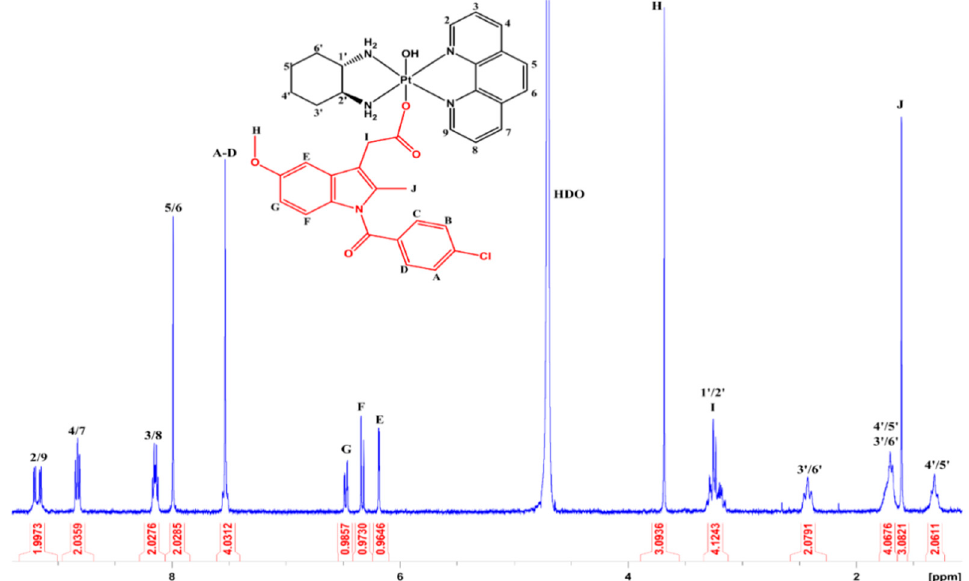
Figure 3. The 1 H NMR spectrum of [Pt(Phen)(SSDACH)(Indomethacin)(OH)](NO 3 ) 2 ( 1 ) in D 2 O at 298 K. Insert: The chemical structure of 1 , with assigned numbers/letters.